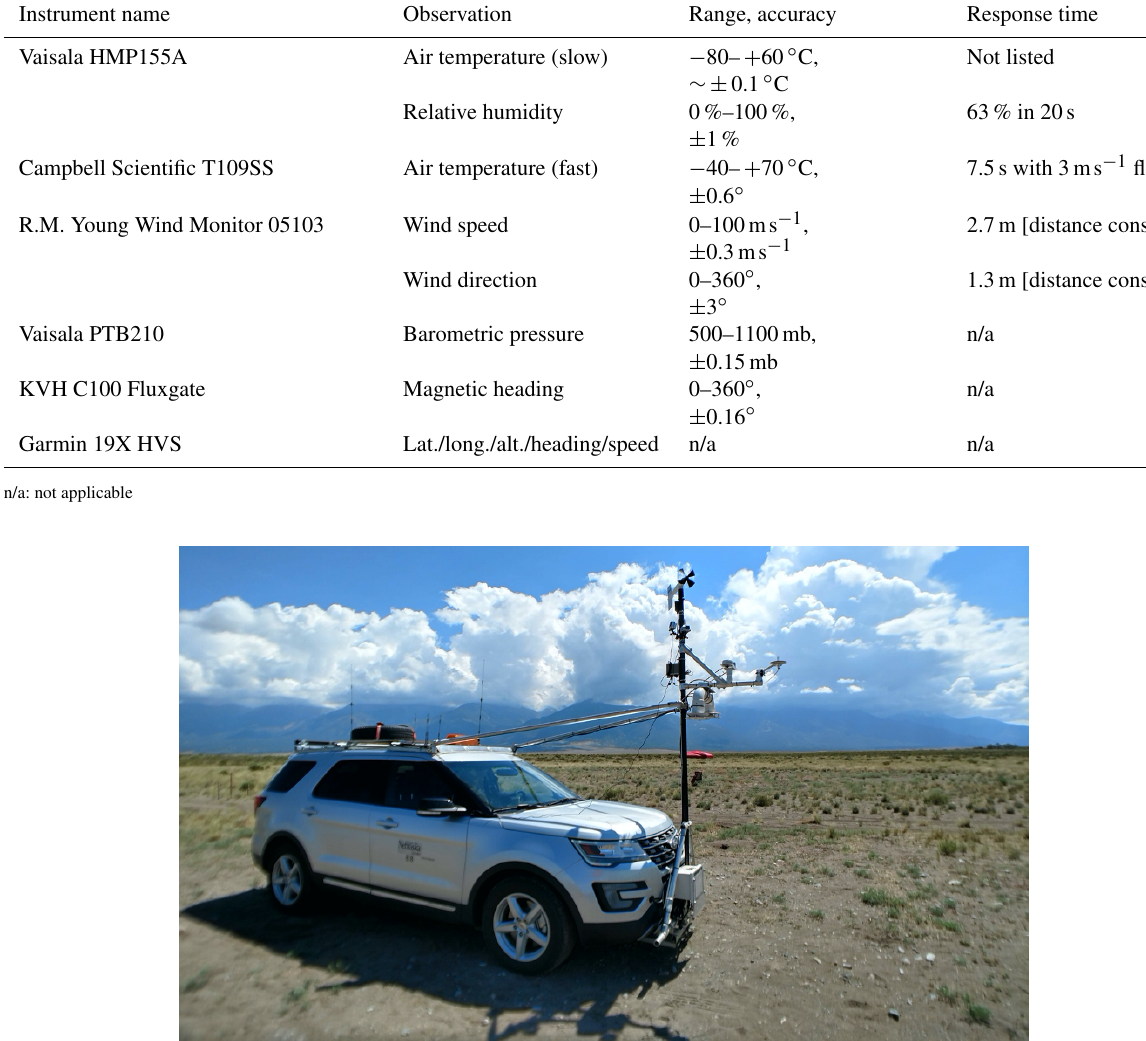
Figure 3. The UNL CoMeT vehicles, as deployed during